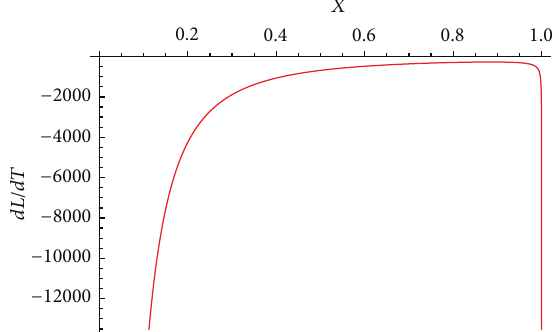
Figure 1: Plots of 𝑑𝐿/𝑑𝑇 versus the parameter 𝜒 for the RN-AdS black hole. We have set 𝑞 = 1 and 𝑑 = 4